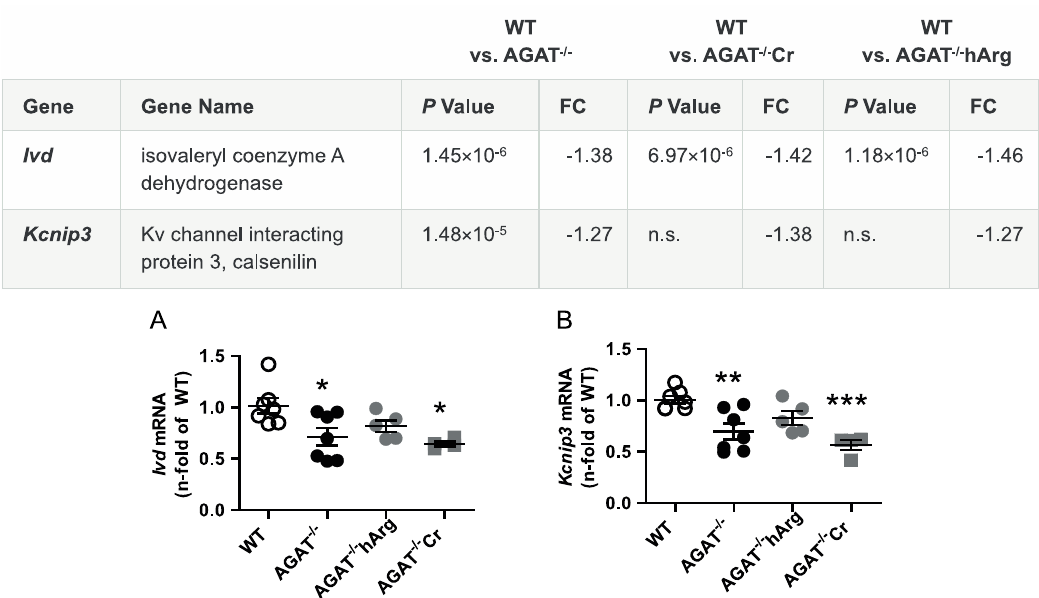
Figure 4. Validation of potentially hArg ‐ dependent candidate genes by qPCR. Relative mRNA expression of Ivd ( A ) and Kcnip3 ( B ) in the brain. Each data point represents an individual mouse. * p < 0.05, ** p < 0.01 and *** p < 0.001 versus WT. WT ( n = 7), AGAT − / − ( n = 7), AGAT − / − hArg ( n = 5), AGAT − / − Cr ( n = 4). The table shows the respective microarray data. Abbreviations: FC, fold change; n.s., not significant.